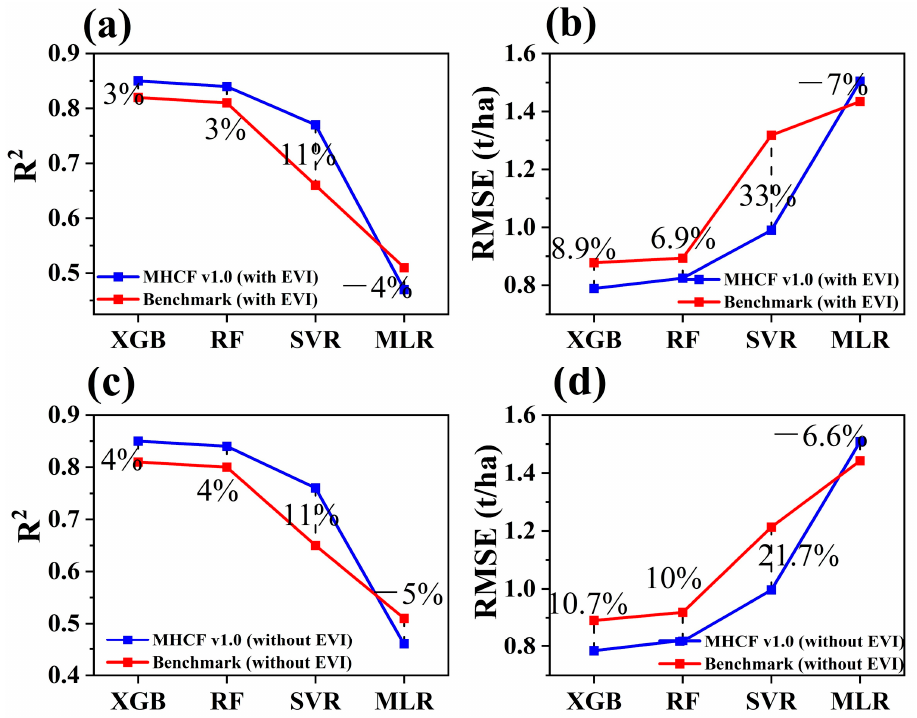
Figure 4. Model performance. ( a , c ) R 2 of MHCF v1.0 and Benchmark with EVI or without EVI, respectively; ( b , d ) RMSE (t/ha) of MHCF v1.0 and Benchmark with EVI or without EVI, respectively.